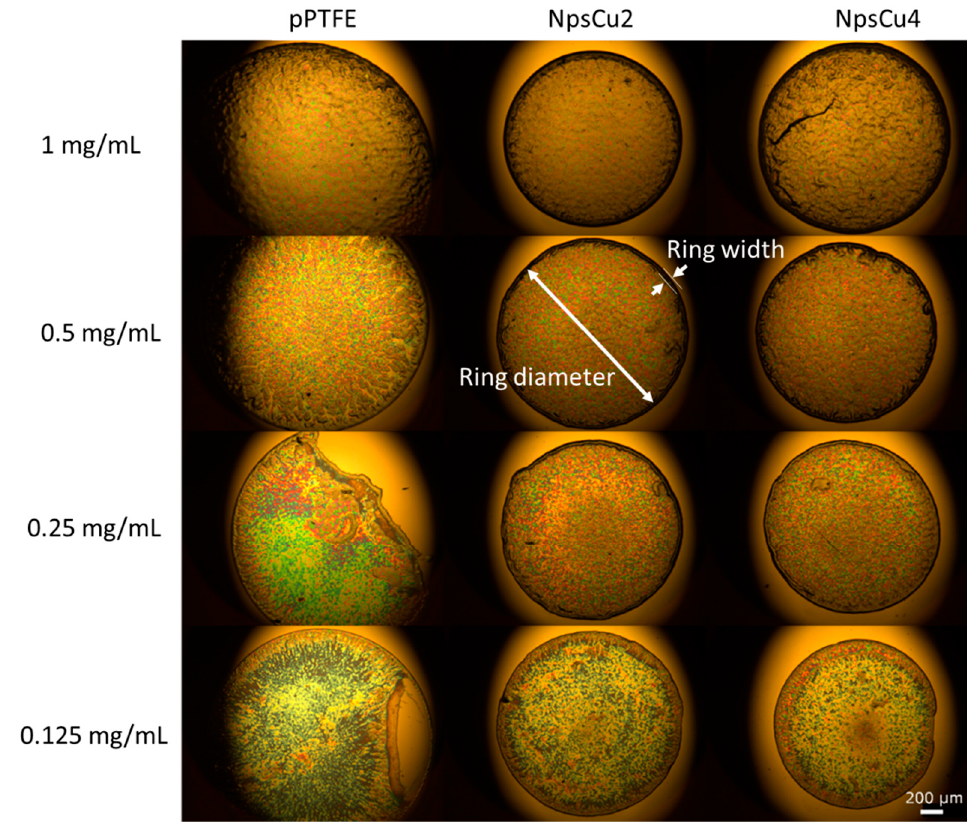
Figure 4. White light images of formed patterns after evaporation of DPPC liposome suspension at four concentrations on three different substrates.